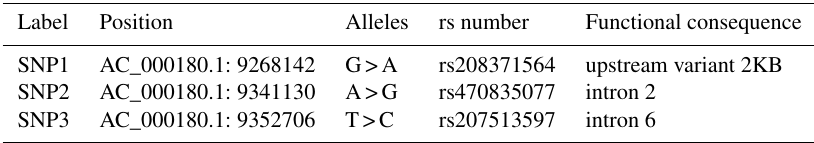
Table 2. Details of primers and restriction enzymes used for genotyping.